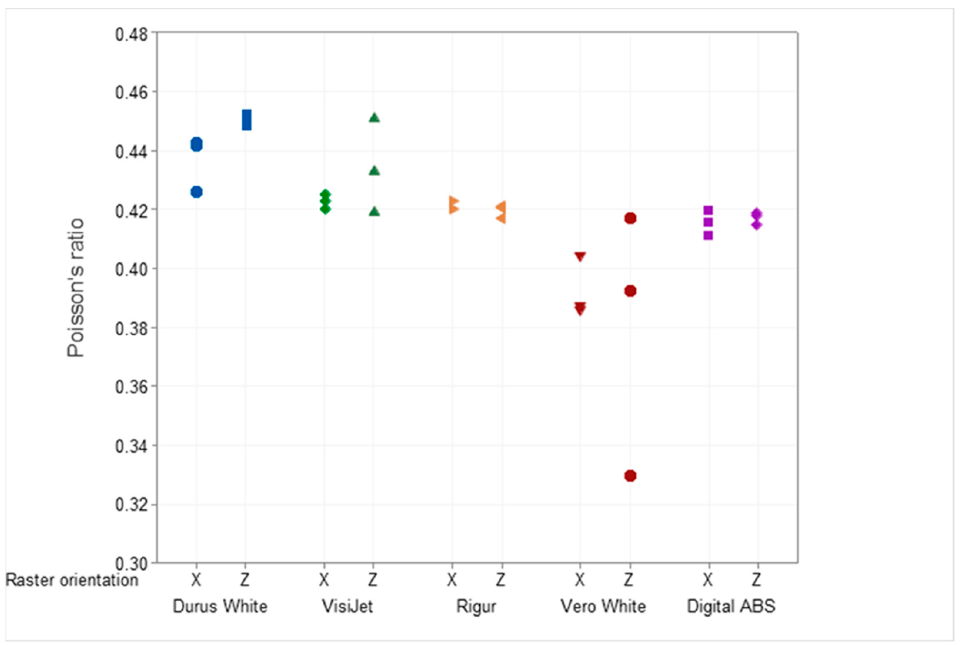
Figure 8. Poisson’s ratio was obtained during the test for Durus, VisiJet, Rigur, Vero, and ABS ma- terials.